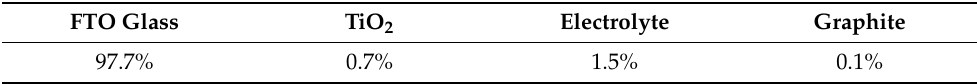
Table 2. Estimated composition of the DSSC cullet in weight percentage. FTO